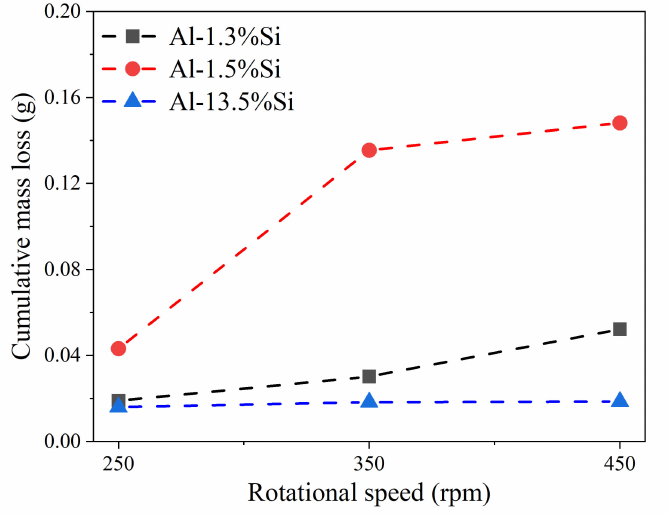
Figure 9. Cumulative mass loss vs. rotational speed plot as a function of alloy